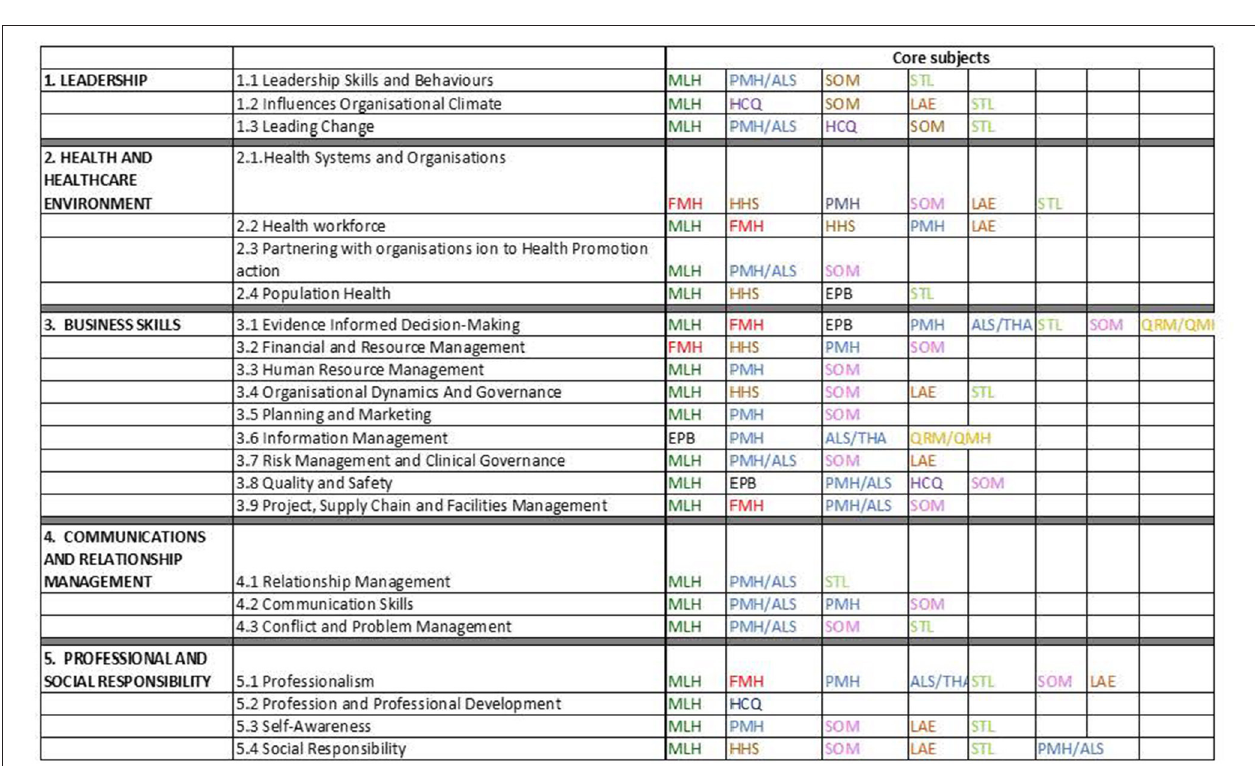
expected demands of health managers projects by the